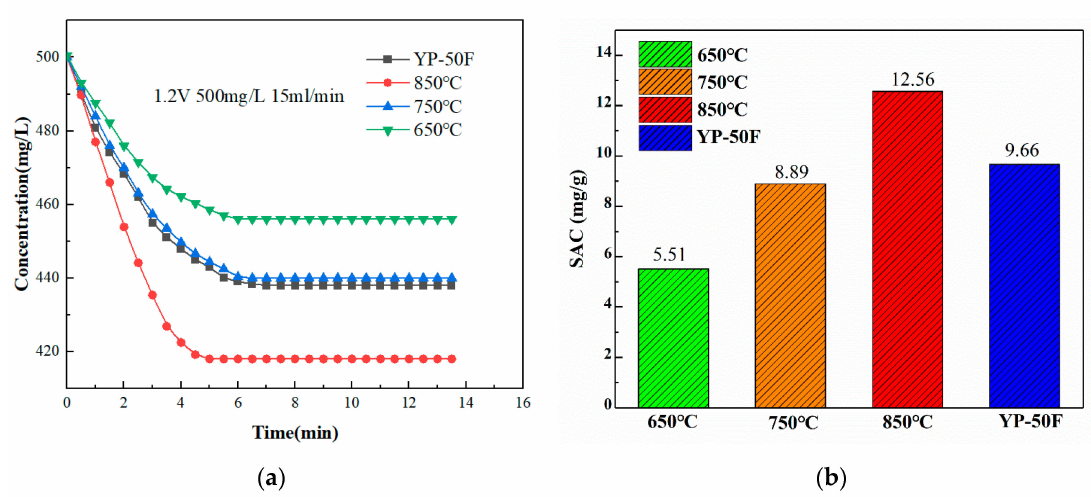
Figure 13. ( a ) Concentration-time curves of YP-50F and N-doped layered porous carbon. ( b ) SAC of YP-50F and N-doped layered porous